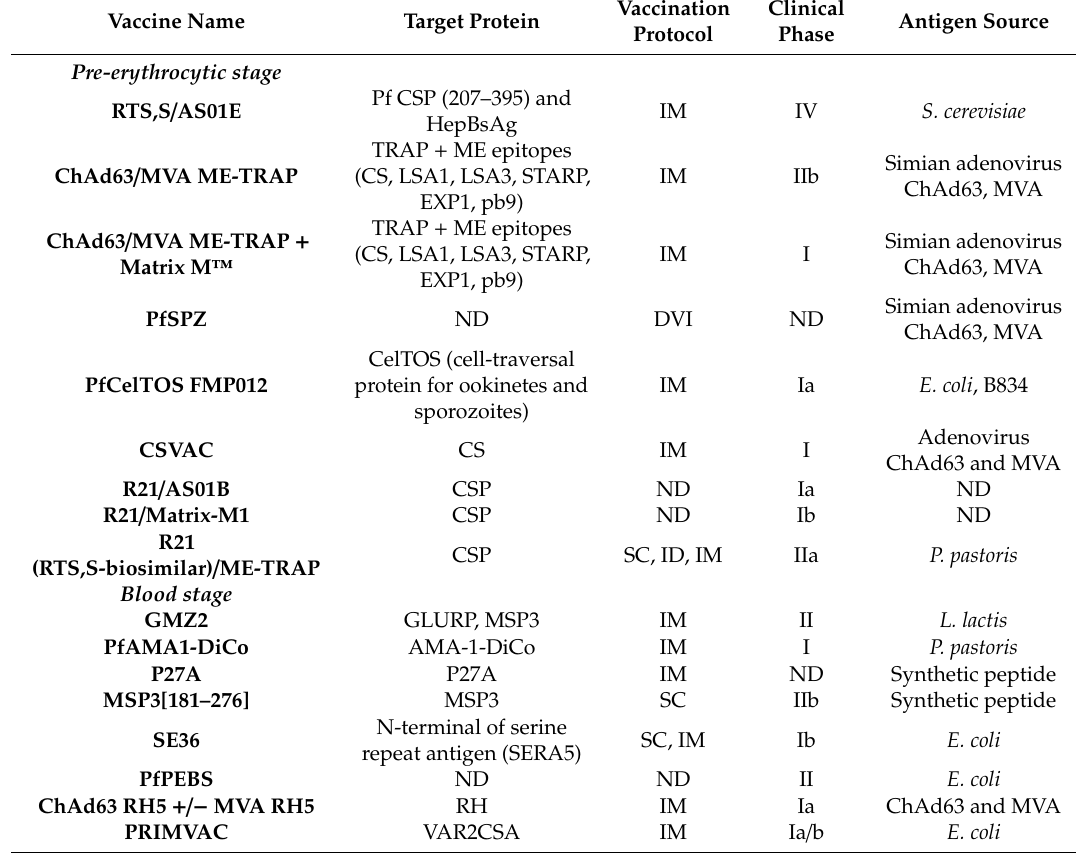
Table 3. Recent clinical trials on vaccines against P.